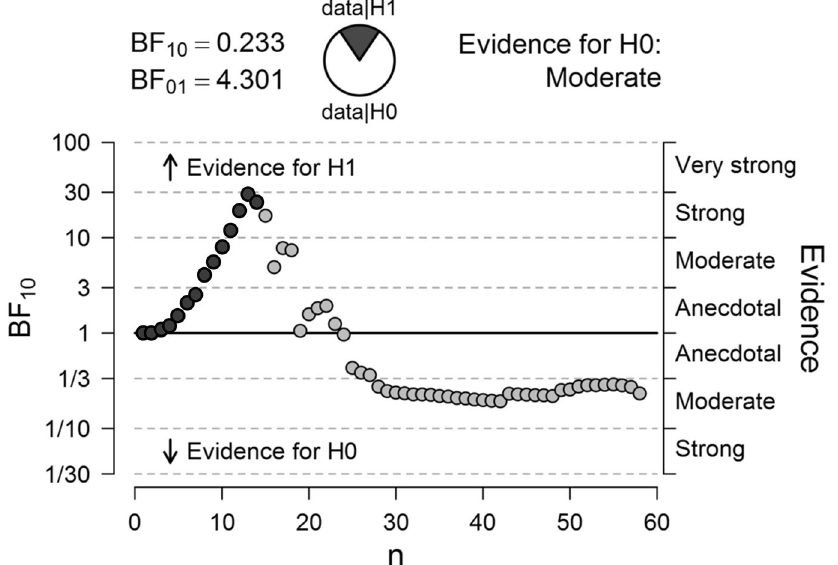
Figure 4. Sequential analysis showing progression of the Bayes Factor (BF) as new participants (n) enter the analysis. Values above 1 represent evidence for a correlation between dopamine synthesis capacity in the left caudate nucleus and a motivation effect on Stroop interference on uninformed trials, whereas values below 1 represent evidence against a correlation. Each dot represents the BF after inclusion of the next participant. Dark grey dots represent the 14 participants from Aarts et al. entered first; light grey dots represent the 44 participants from the current study. Order of including participants within each group was at